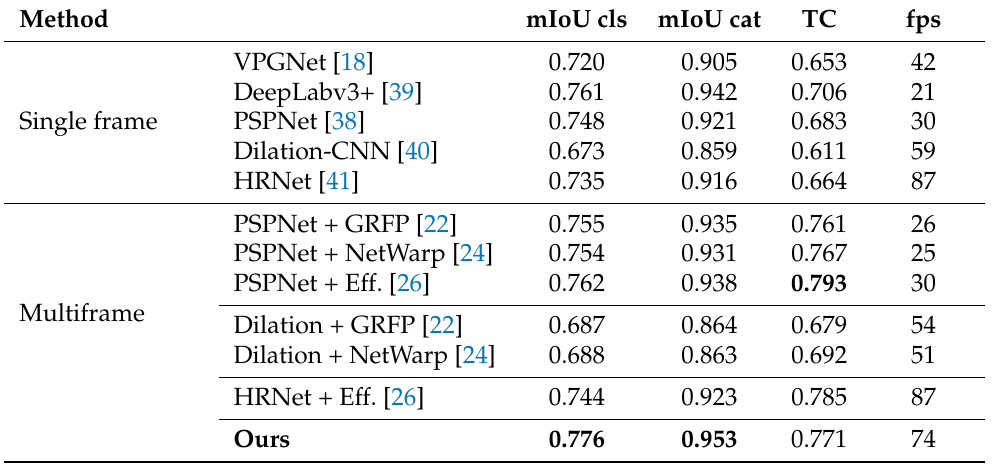
Table 4. Segmentation score for lanes and road markers on the Apolloscape lanemark segmentation dataset by different methods.